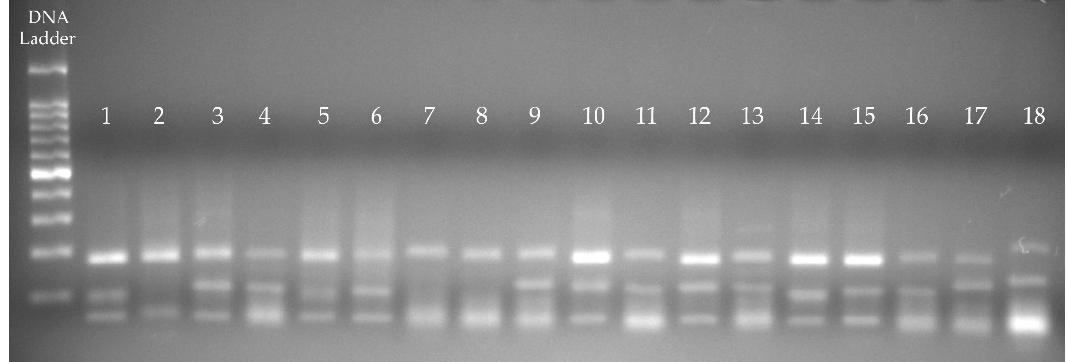
Figure 1. RFLP analysis of the 384 bp fragment ( G. intestinalis ) obtained from samples from dogs in the central region of Mexico. Lanes 1, 3–6, and 9–18 show the banding pattern that corresponds to subassemblage AI (190, 100 and 70 bp). Lanes 2, 7, and 8 show the banding pattern for subassemblage AII (210 and 70 bp).